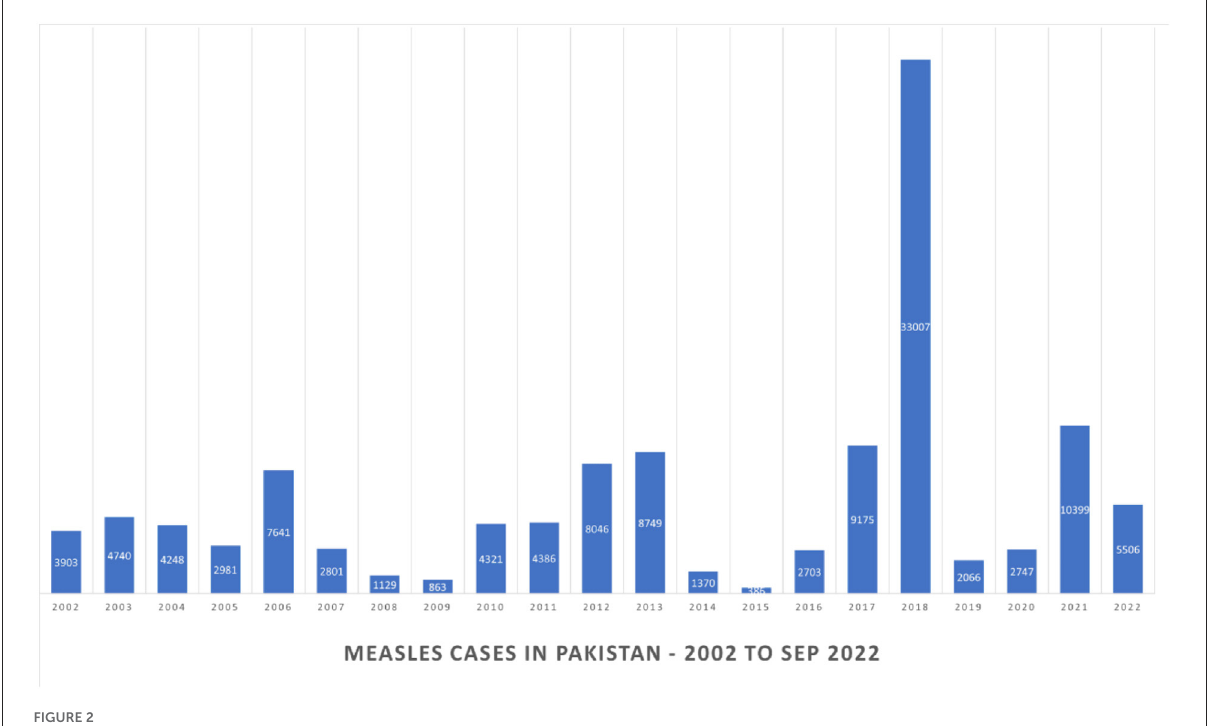
FIGURE2 Reported measles cases in Pakistan—past 20 years.